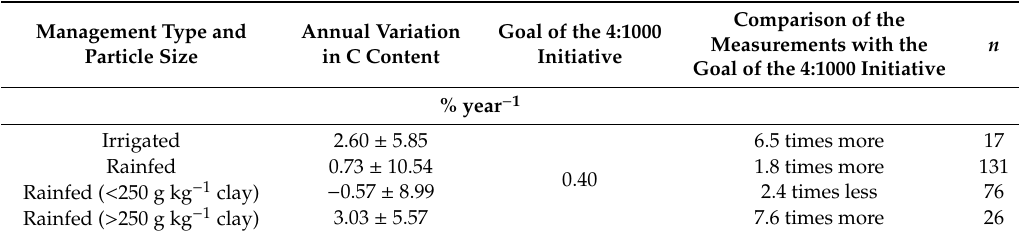
Table 4. Percentage of annual variation of the carbon content in the areas evaluated and their comparison with the goal established by the 4:1000